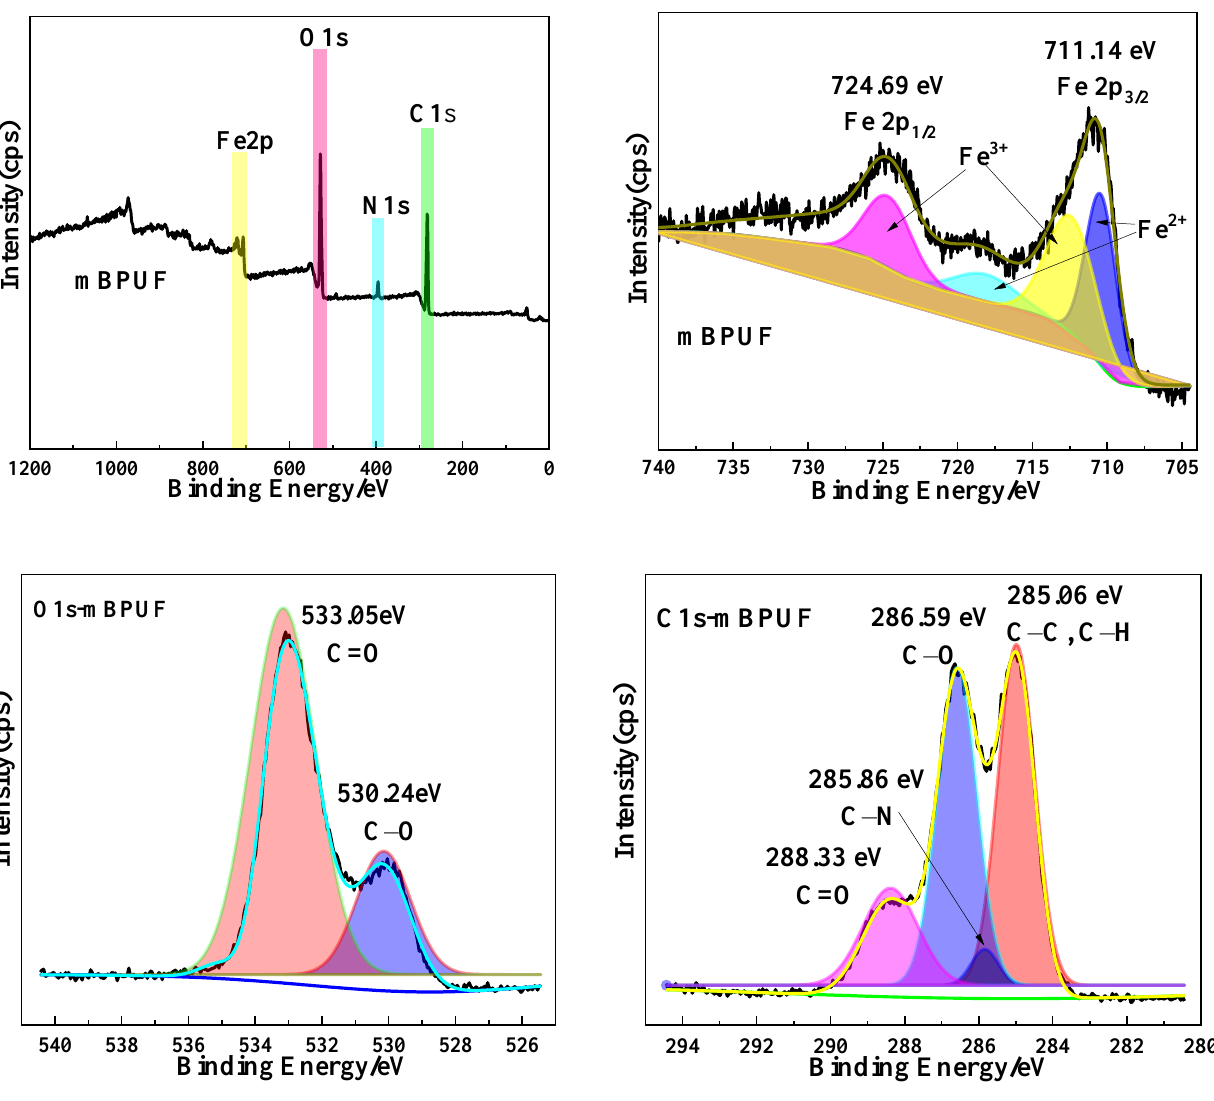
Figure 4. XPS curves of the mBPUF composite.